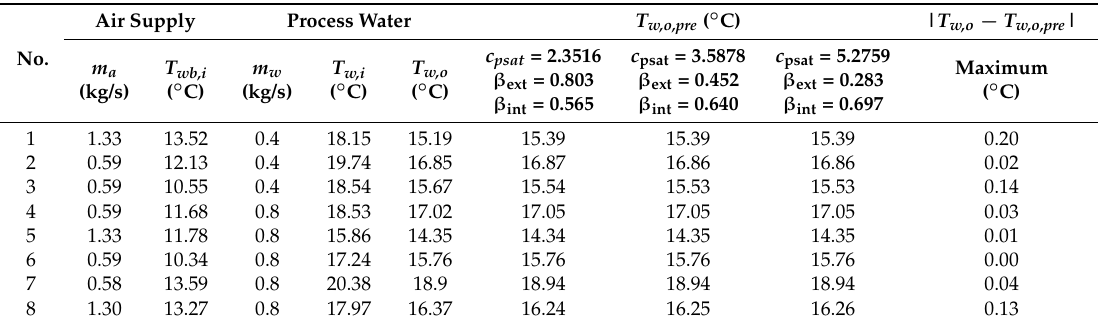
Table 1. Comparison between the predicted thermal performance and the measurements of the PCFCWCT.